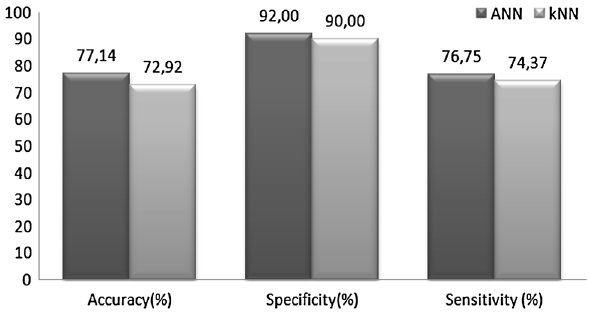
Fig. 10 Overall performances of MLPNN and k NN classifiers